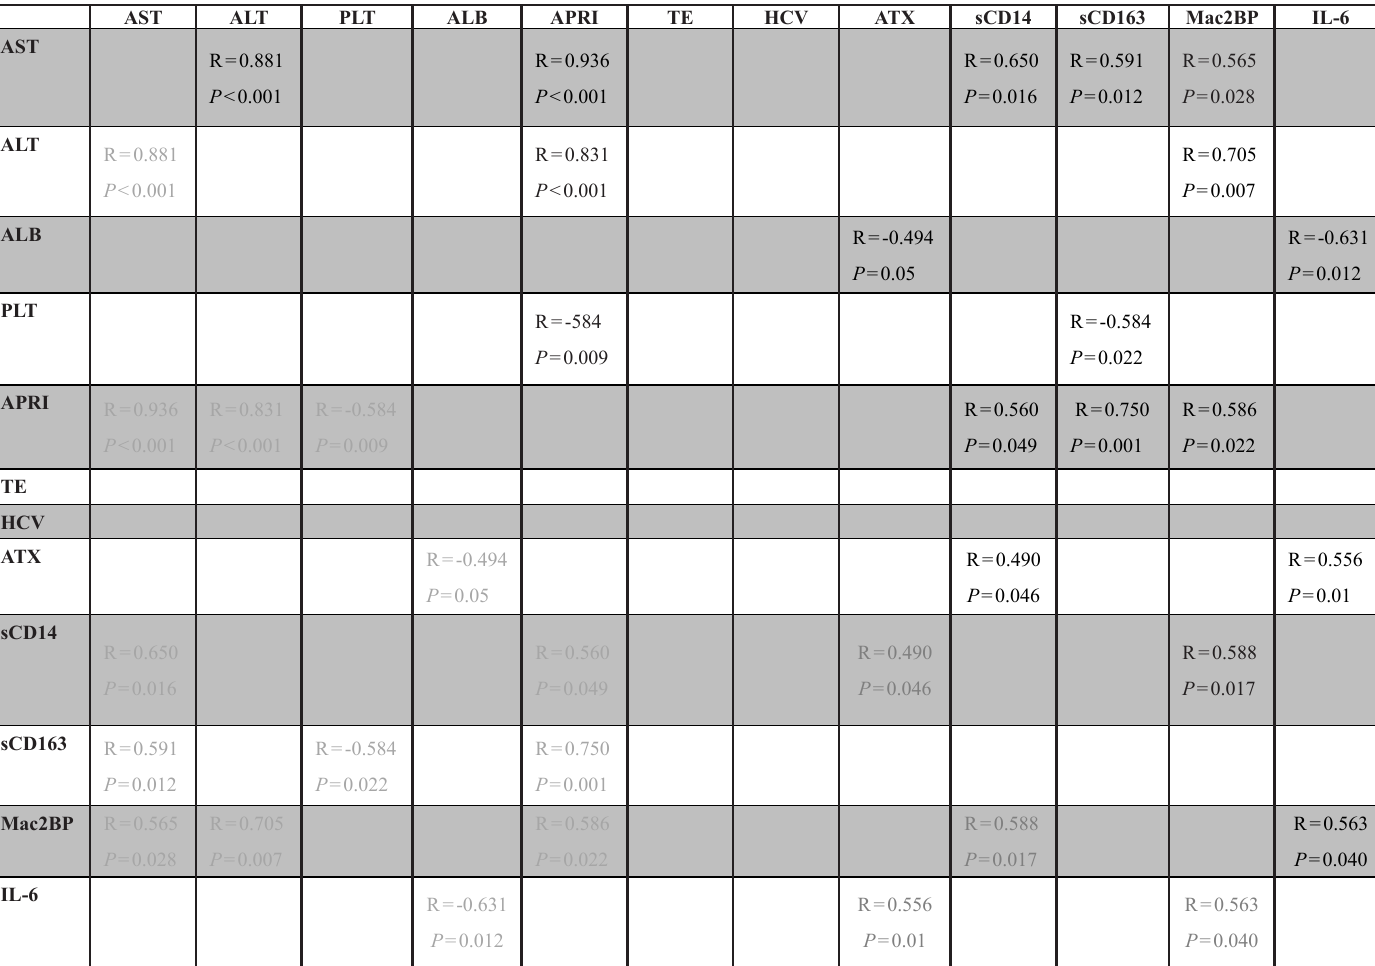
Table 2. Correlations between parameters before IFN-free DAA